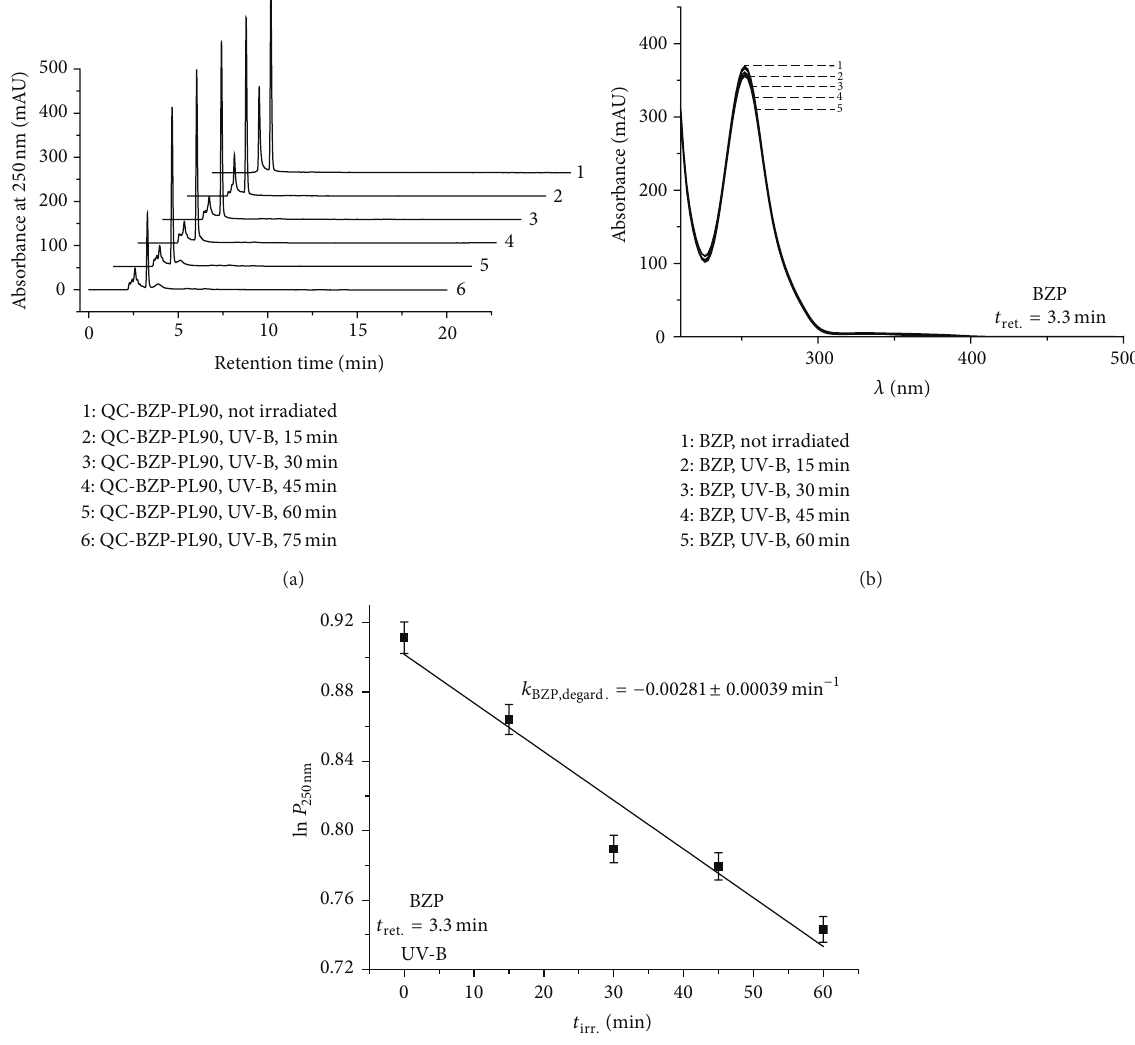
, of 3.3 min). (b) Changes in BZP absorption ret . = 3.3 min), as a result of the increasing UV-B irradiation periods (𝑡 ) . (c) ret . irr . = 3.3 min) integrated areas as a result of the ret . = 𝑓(𝑡 ). The corresponding bleaching rate constant and the related error bars are shown in nm irr .